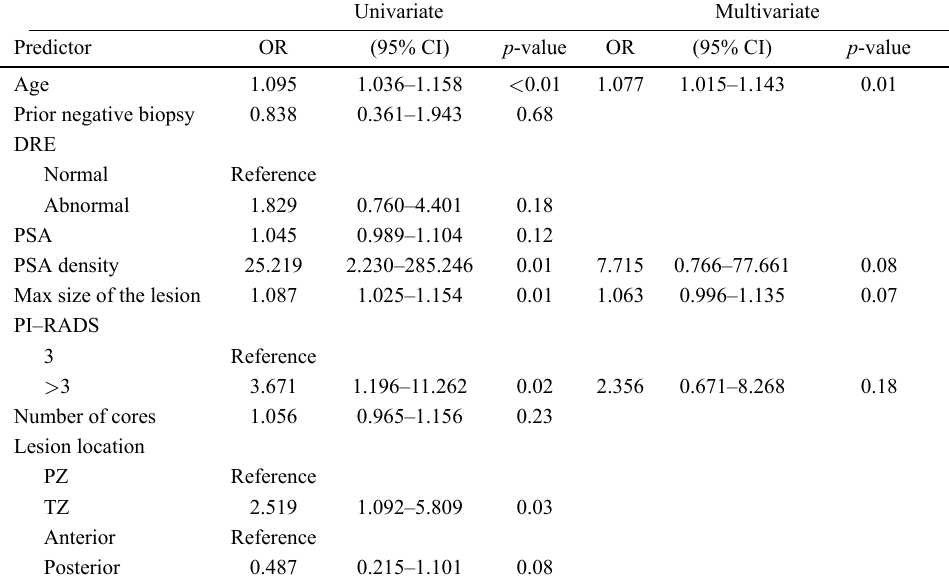
Table 2. Logistic regression of the predictors of